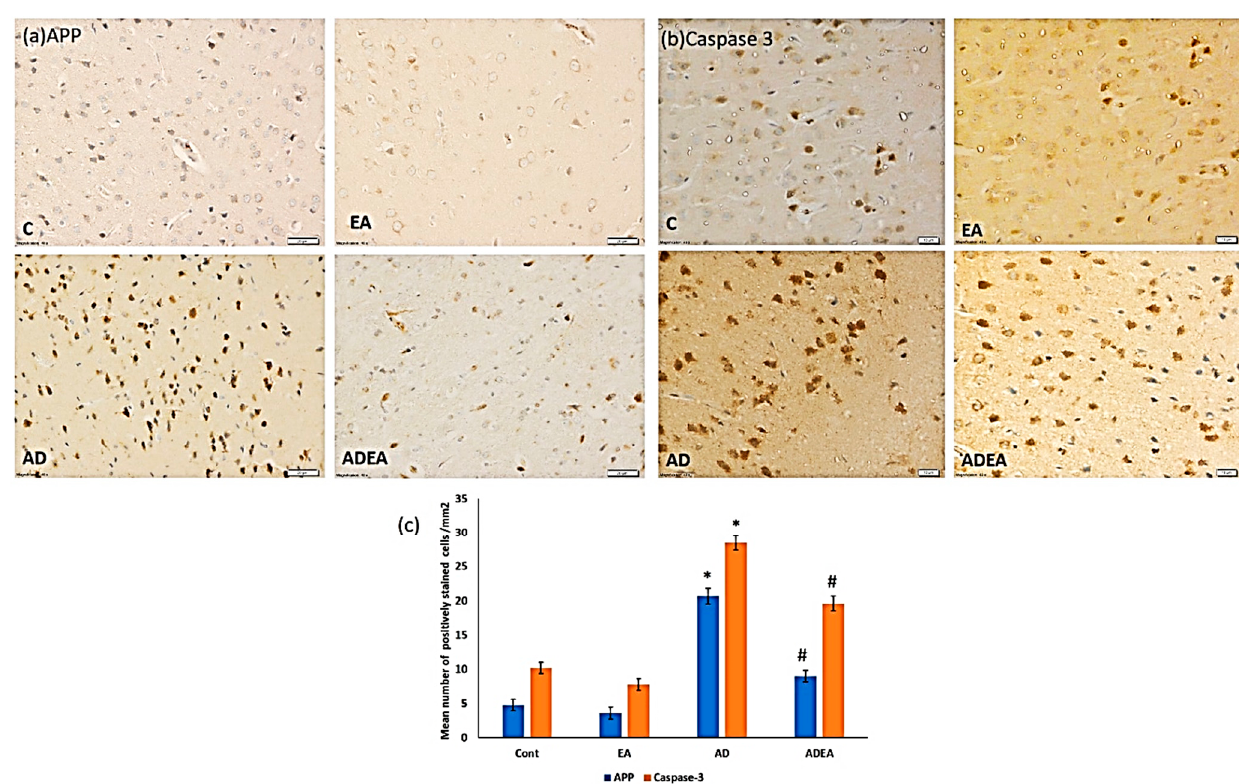
Figure 6. ( a – c ). Photomicrographs of ERC immunostained sections showing upregulated expression of ( a ) APP and ( b ) caspase-3 in the neurons from the AD group compared to the other groups. (Immunohistochemistry, magnification ×40, scale bar 20 µm).) ( c ) Quantitative analysis of the mean number of APP- and caspase-3-positively immunostained neurons per square millimeter. One-way ANOVA was used, and Fisher’s LSD t -test was applied when equal variance could be assumed. * Significantly different from the control, EA, and ADEA groups at p ≤ 0.05. # Significantly different from the AD group at p ≤ 0.05.